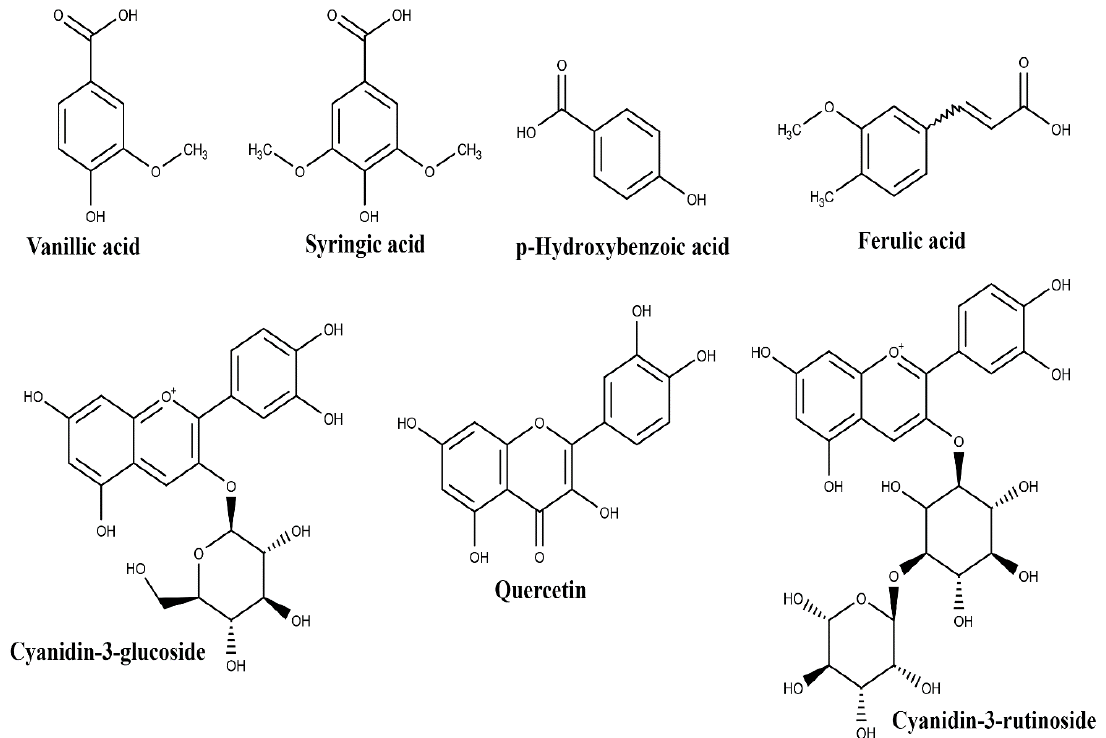
Figure 1. Structures of the main compounds identified in Euterpe oleracea Mart. fruit.